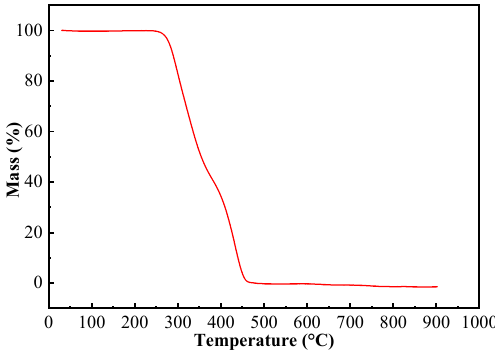
Figure 6. TGA curve of (ChCl-MAA)DES@MIPs.